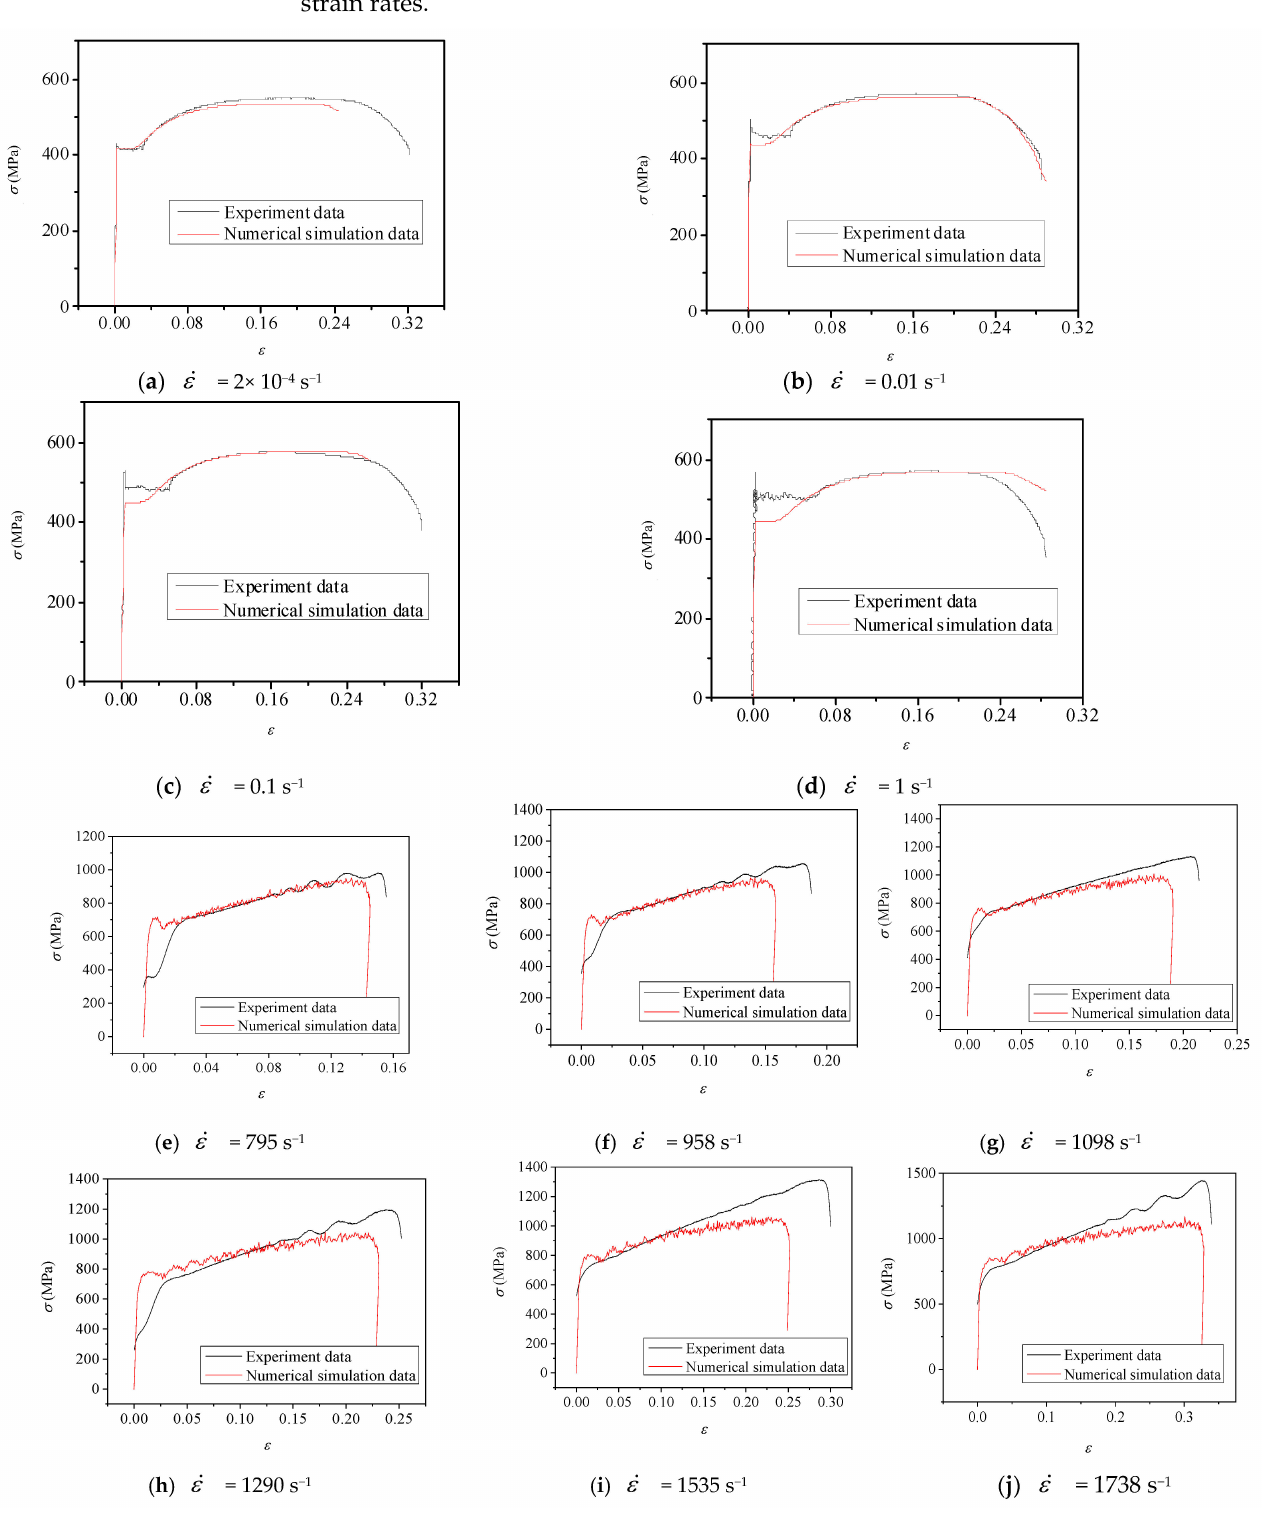
Figure 21. Comparison of numerical and test results at − 40 ◦